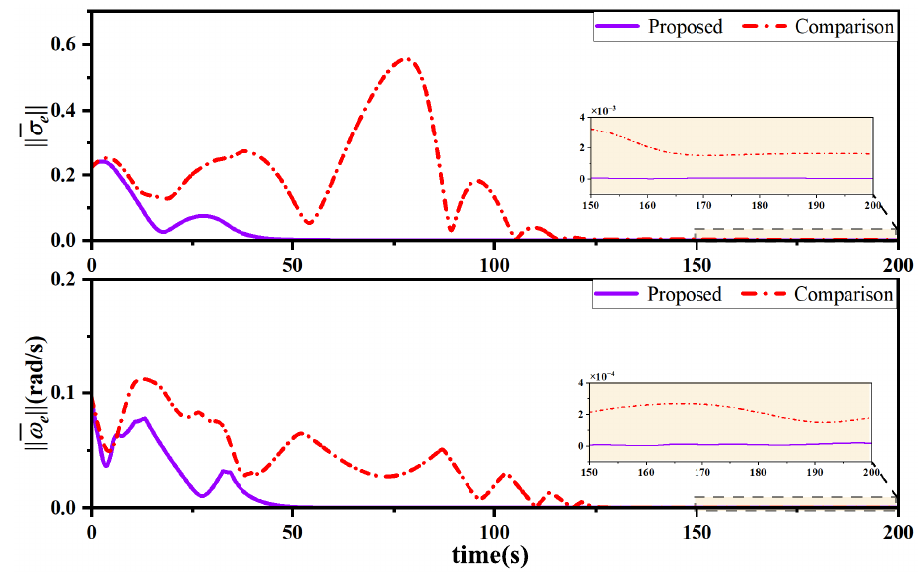
Figure 8. The Euclidean norm evolution trajectories of averaged attitude tracking error ¯ σ e and averaged angular velocity tracking error ¯ ω e